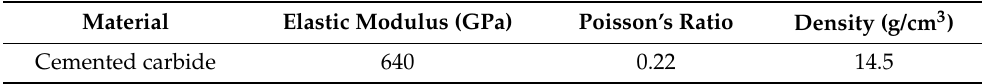
Table 2. Material properties of end milling cutter.